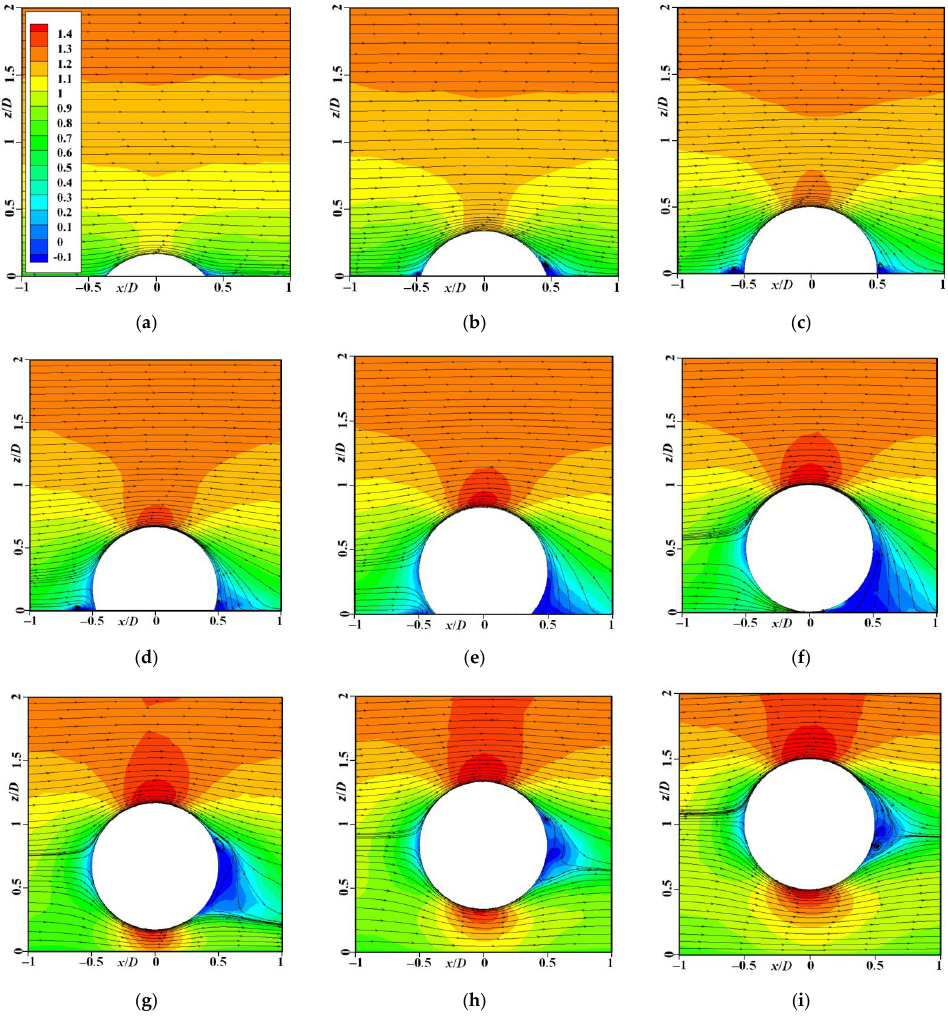
Figure 7. Mean streamlines and normalised mean streamwise velocity ( U / U 10 ) in the centre plane of the domain: ( a ) Model 2; ( b ) Model 4; ( c ) Model 6; ( d ) Model 8; ( e ) Model 10; ( f ) Model 12; ( g ) Model 14; ( h ) Model 16; ( i ) Model 18.